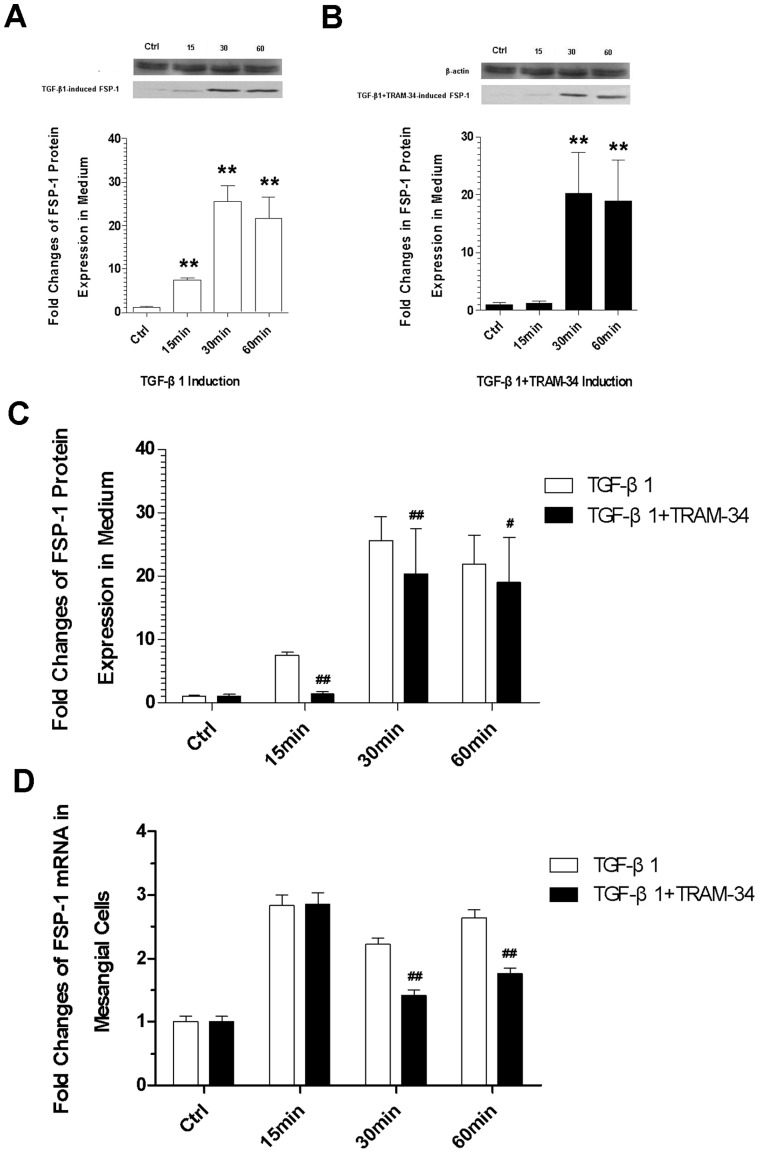
Expression of FSP-1.(A) Immunoblotting analysis of TGF-β1-induced FSP-1 protein expression; (B) Immunoblotting analysis of TGF-β1+TRAM-34-induced FSP-1 protein expression; (C) The differences between the TGF-β1- and the TGF-β1+TRAM-34-induced FSP-1 protein expression; (D) RT-PCR assessments for FSP-1 gene expression (* P<0.05 and ** P<0.01versus control; # P<0.05 and ## P<0.01 versus the TGF-β1-induced; n = 5).